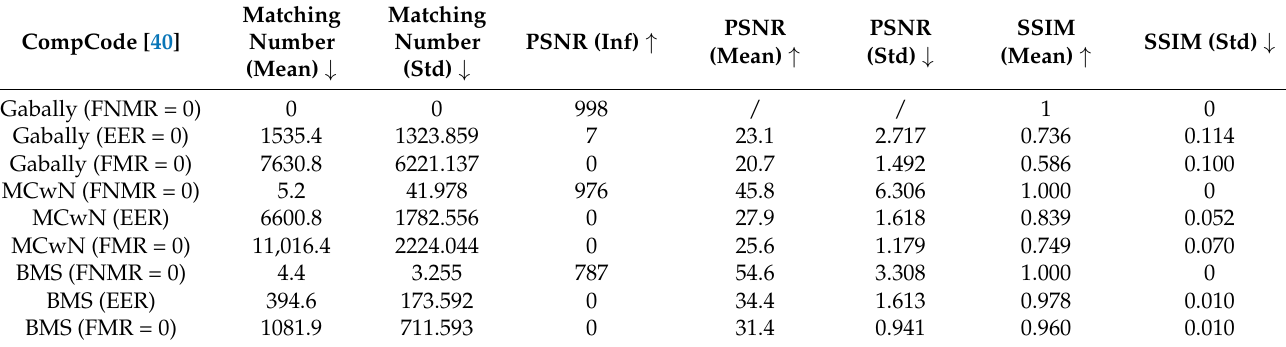
Table 7. Attack performance of CompCode [40].